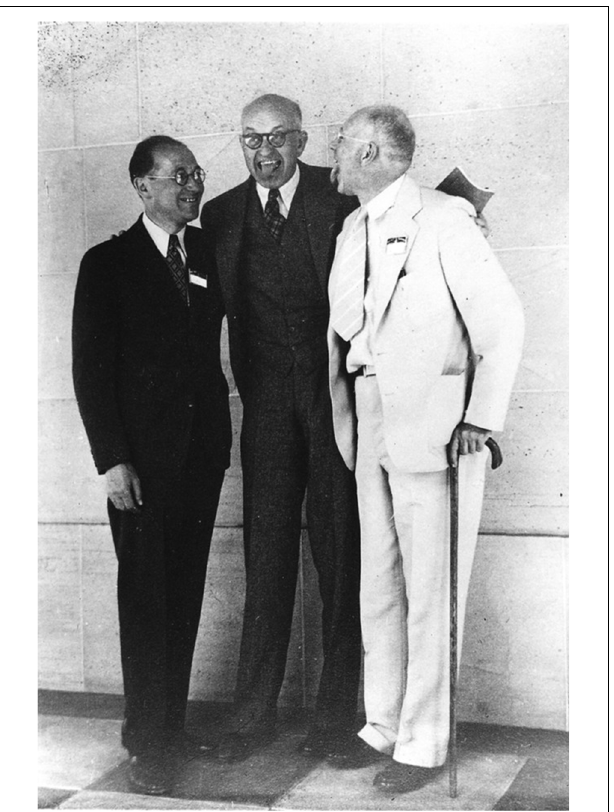
FIGURE 3 | From left to right: Kurt Lewin, Edward Tolman, and Clark Hull at the 47th Annual Meeting of the American Psychological Association in 1939. Tolman and Hull stick their tongues out at each other as a playful expression of their opposing views on learning (from the Geoffrey W. H. Leytham collection, Archives of the History of American Psychology, the Drs Nicholas and Dorothy Cummings Center for the History of Psychology, University of